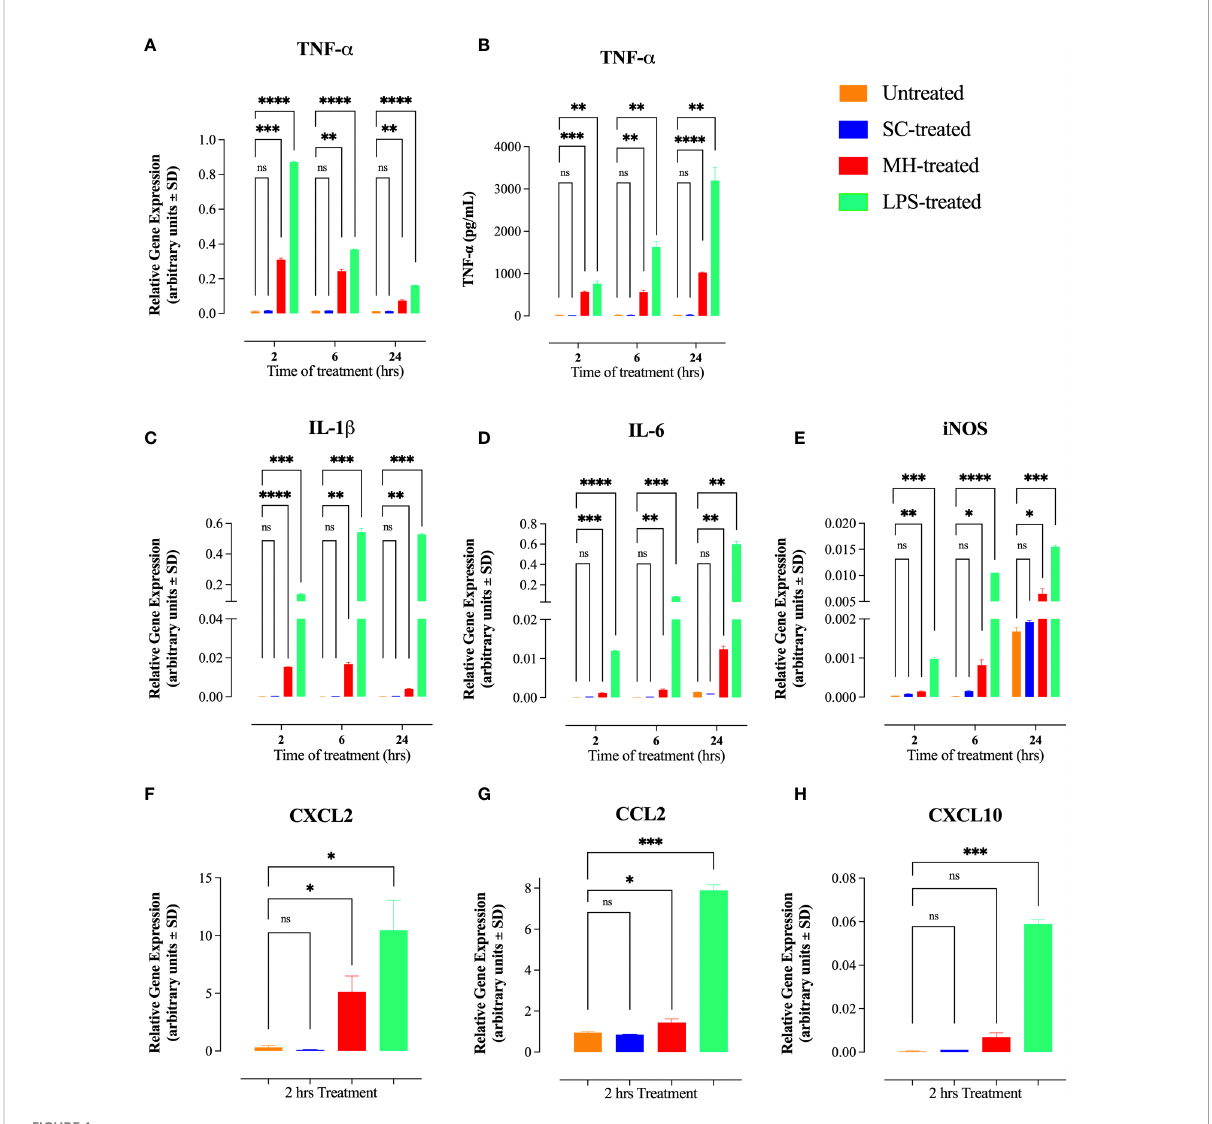
FIGURE 1 MH treatment induces in fl ammatory cytokines and chemokines in RAW 264.7 macrophages. (A, B) mRNA expression (A) and protein level (B) of TNF- a following 2, 6 and 24 hours of treatment with SC, MH or LPS. (C-E) Gene expression analysis of IL-1 b (C) , IL-6 (D) , and iNOS (E) following 2, 6, or 24 hours of the indicated treatment. (F-H) mRNA expression of CXCL2 (F) , CCL2 (G) , and CXCL10 (H) chemokines following 2 hours